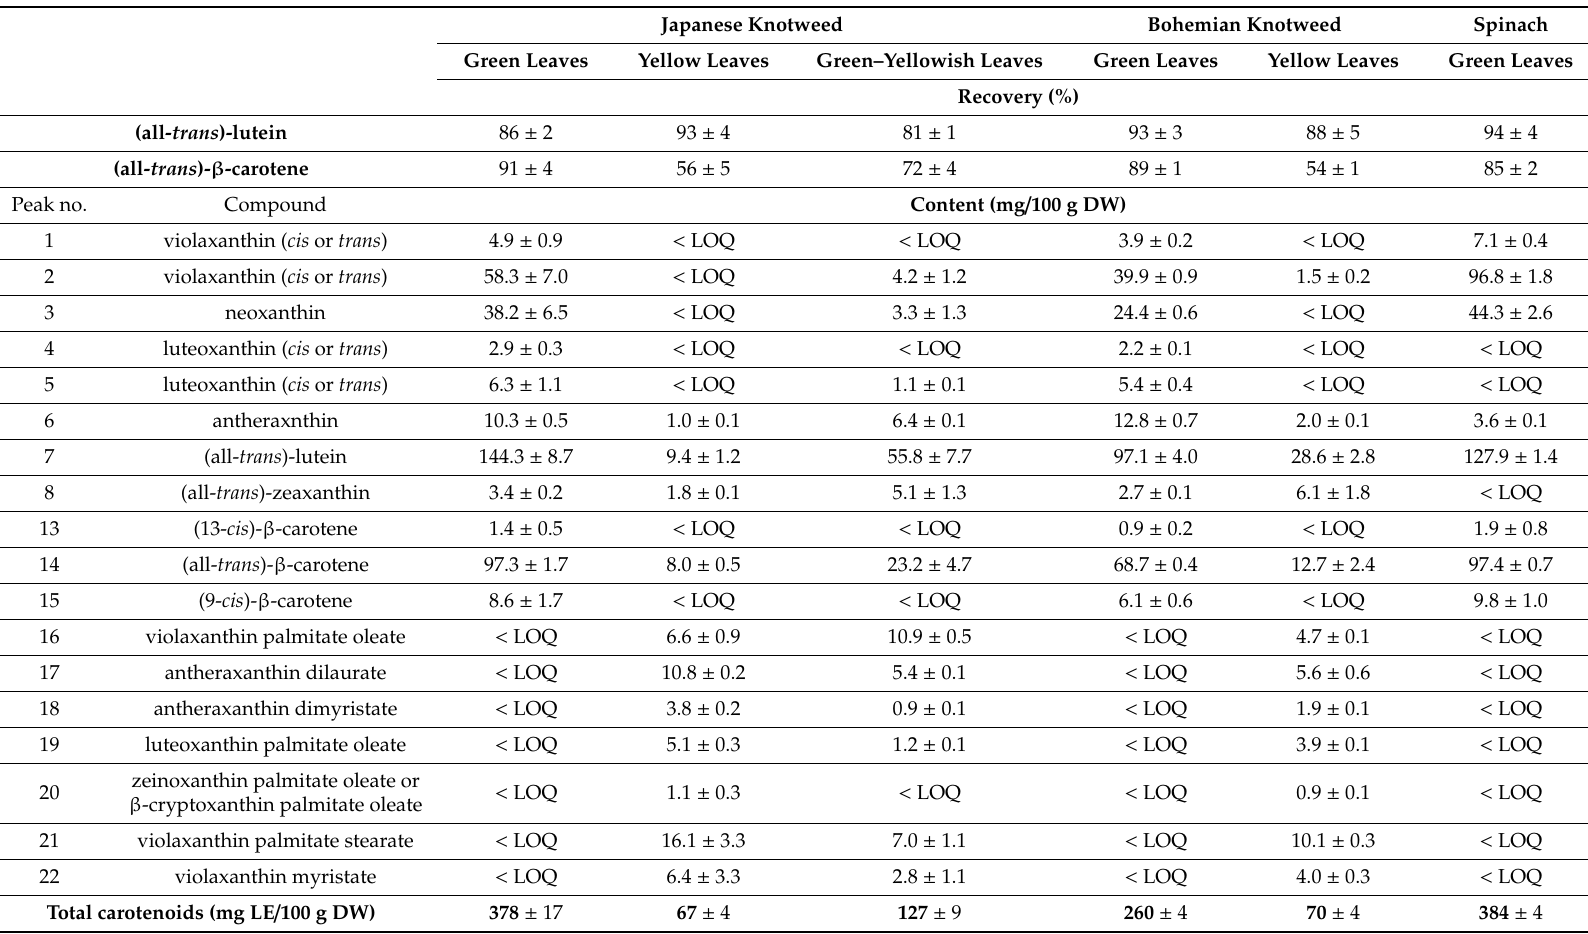
Table 2. Average extraction recovery and contents of carotenoids found in Japanese and Bohemian knotweed leaf extracts and spinach leaf extract. Limit of quantitation (LOQ) for (all- trans )-lutein and for analytes which were quantified based on (all- trans )-lutein calibration was determined as 0.8 mg / 100 g (S / N > 10, RSD (%) < 1). Recovery and total carotenoid content is expressed as average of duplicate and triplicate measurements, respectively, with standard deviation. Japanese Knotweed Bohemian Knotweed Spinach Green Leaves Yellow Leaves Green–Yellowish Leaves Green Leaves Yellow Leaves Green Leaves Recovery